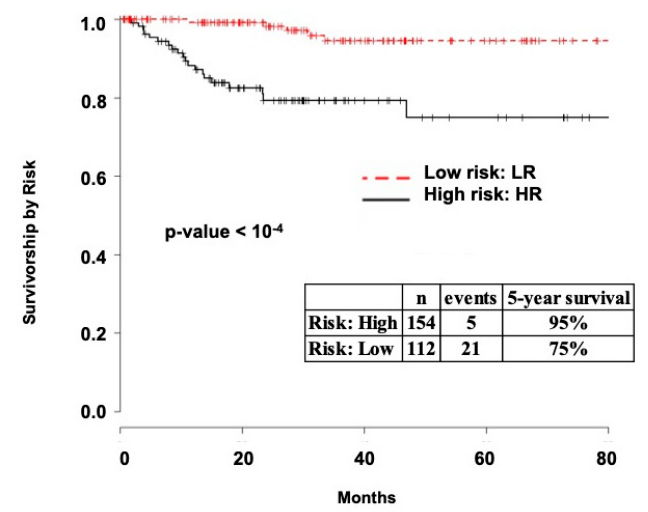
Figure 3. Survival analysis for TCGA endometrial cancer patients. Survival curves for TCGA EEC patients with clinical data stratified by risk. Survival for both UI and TCGA patients was similar when stratified by risk level.